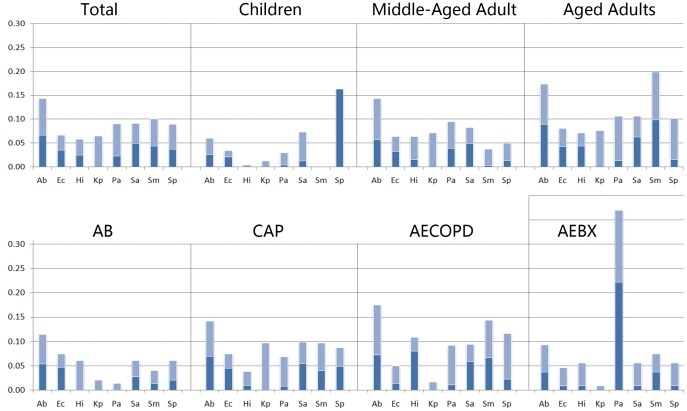
The percentage of bacteria identified as definite (dark blue) and possible (light blue) causative agents in LRTI patients (for the full bacterial names see the legend of

Figure 2

). The patients are classified as: children, ≤14 yr; middle-aged adult, >14 yr but <70 yr; aged, ≥70 yr; AB, acute bronchitis; CAP, community acquired pneumonia; AECOPD, acute exacerbation of COPD; and AEBX, acute exacerbation of bronchiectasis.